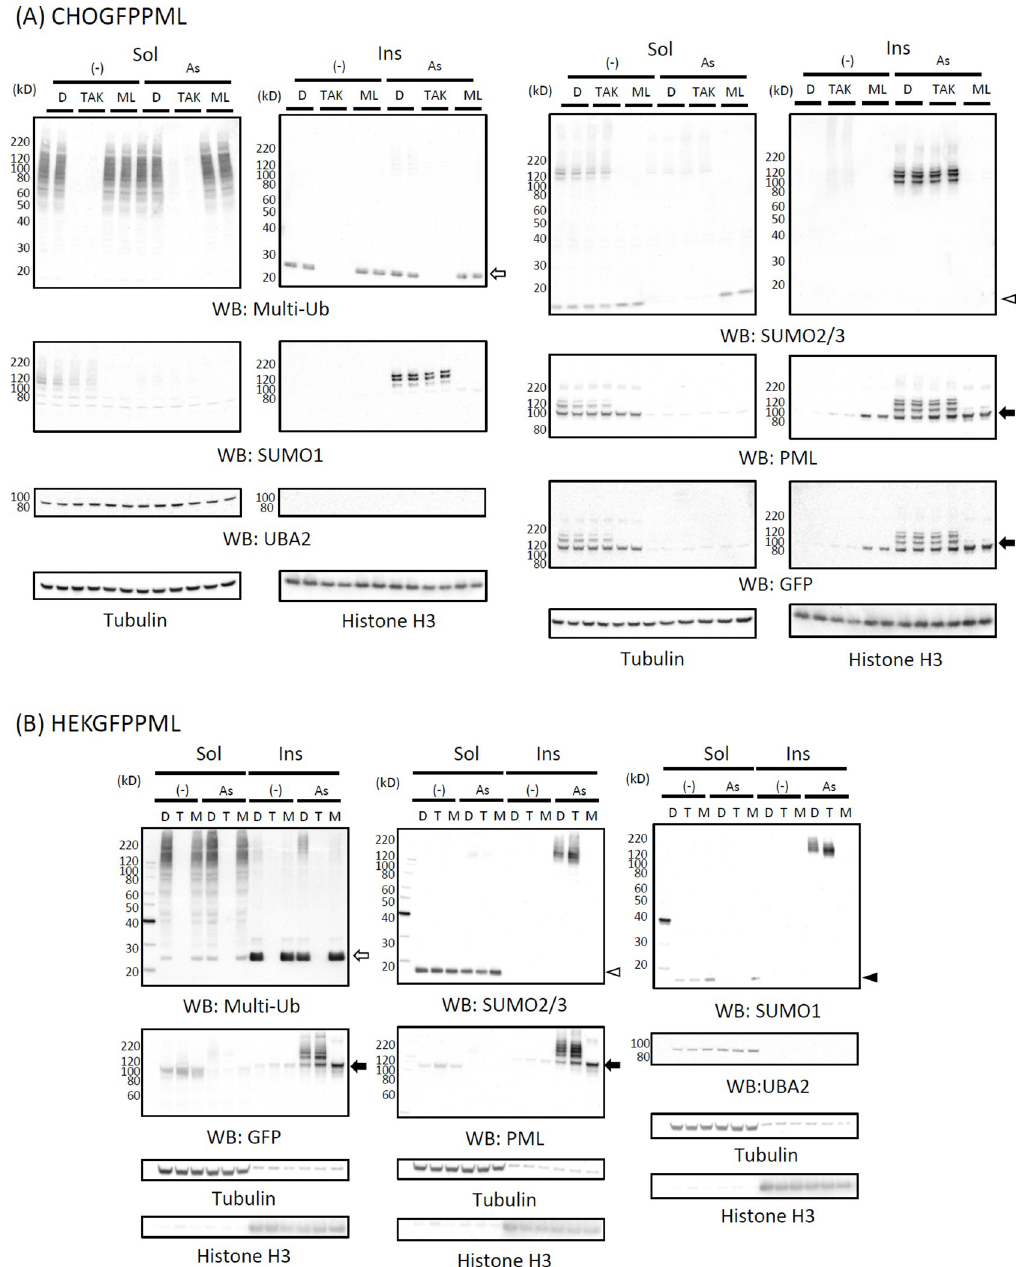
Fig 9. Effects of TAK243 and ML792 on As 3+ –induced biochemical changes of PML in CHOGFPPML (A) and HEKGFPPML cells (B). The cells were pre–treated with 0.1% DMSO, 10 μ M TAK243, or 20 μ M ML792 for 3 h, then further treated with 3 μ M As 3+ or left untreated for 2 h. The RIPA–soluble and–insoluble fractions were prepared as described previously, and the proteins were resolved by SDS–PAGE followed by western blotting. For CHOGFPPML cells, samples following each treatment were obtained from 2 separate wells. The membranes were probed sequentially with the indicated antibodies, then reprobed with a mixture of HRP–tagged anti–tubulin and HRP–tagged anti–histone H3 antibodies. Open arrow, mono–ubiquitinated histone; Closed arrow, GFPPML; Open arrowhead, SUMO2/3 monomers; Closed arrowhead, SUMO1 monomers. toroidal PML-NBs into small granular dot-like PML-NBs in the HEKGFPPML cell nucleus (Fig 2B) indicates that PML-NBs are not rigid aggregates, and that toroidal PML-NBs in HEK cells are more labile than those in CHO cells. Non-spherical PML-NBs are prone to forming